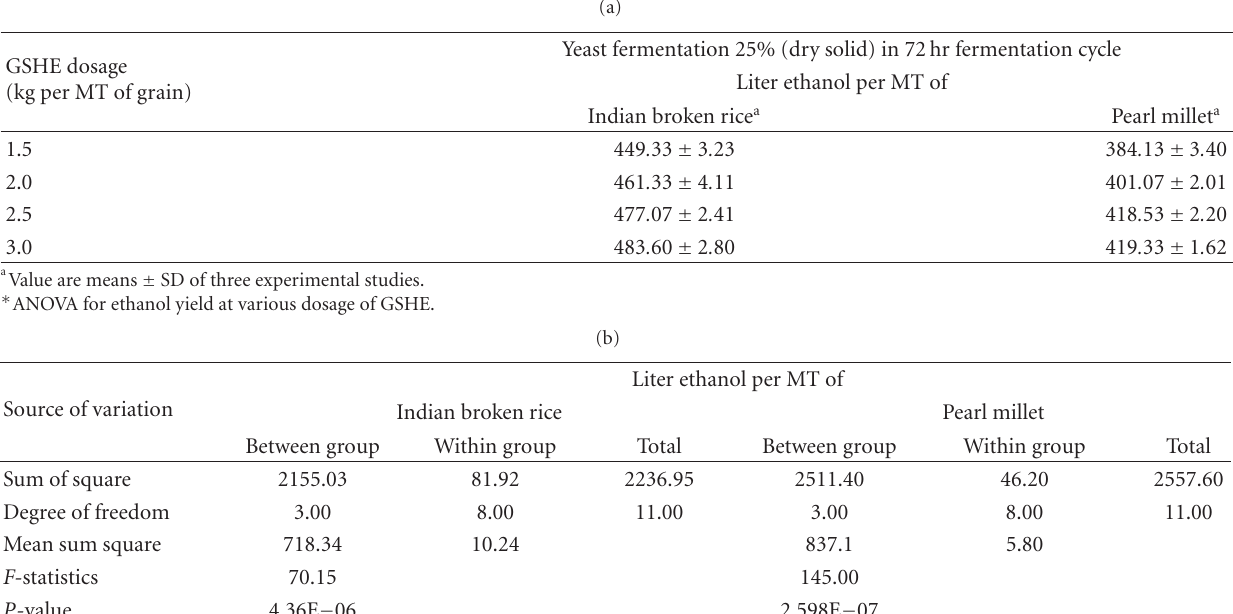
Table 1: Ethanol recovery in liter per MT of grain in 72 hr of cycle at various dosage of GSHE under yeast fermentation having 25% dry solid of broken rice and pearl millet ∗